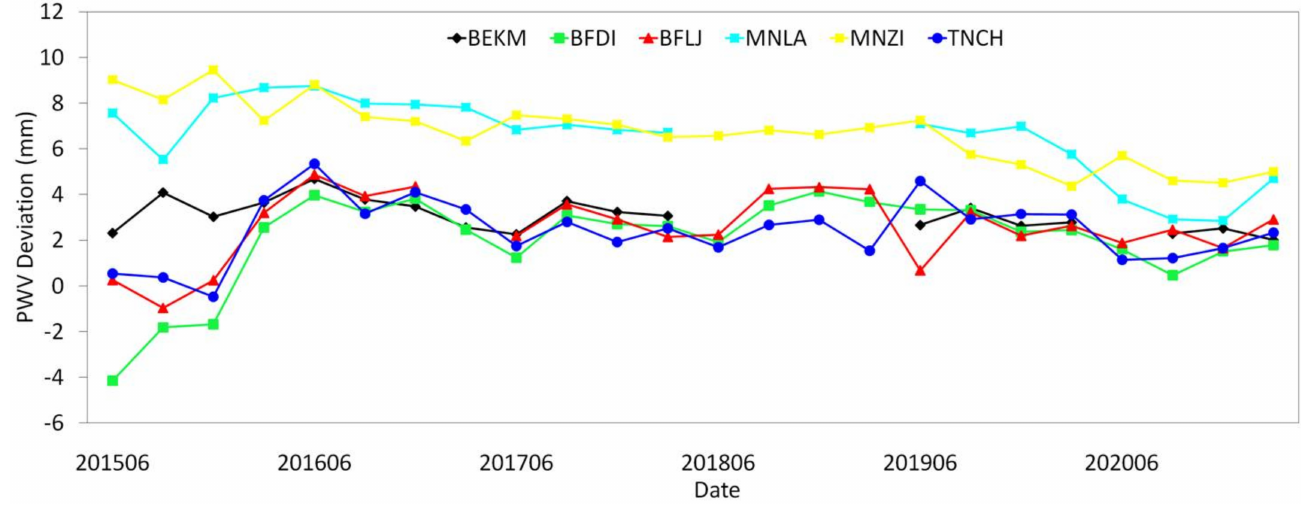
Figure 4. Monthly mean deviation of TCWV and PWV for 6 stations (cyan: MNLA; yellow: MNZI; blue: TNCH; black: BEKM; green: BFDI; red: